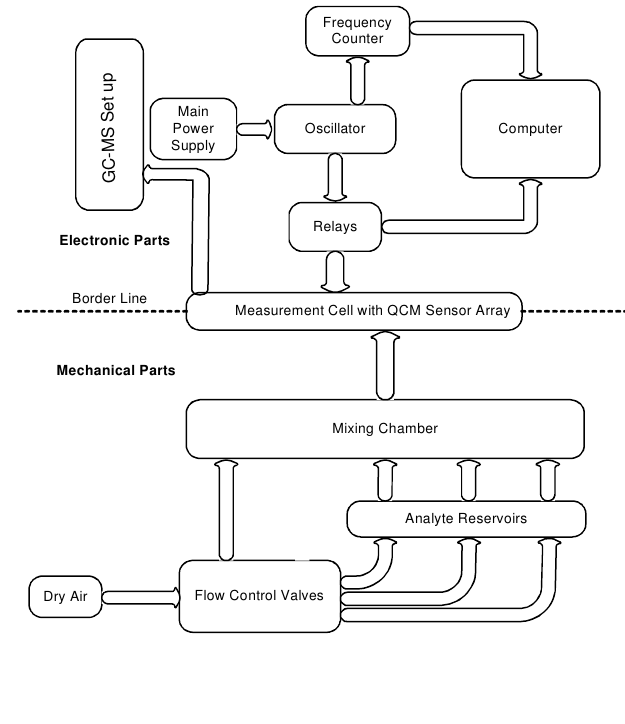
Figure 9. Flow sheet diagram of measuring components of the QCM based